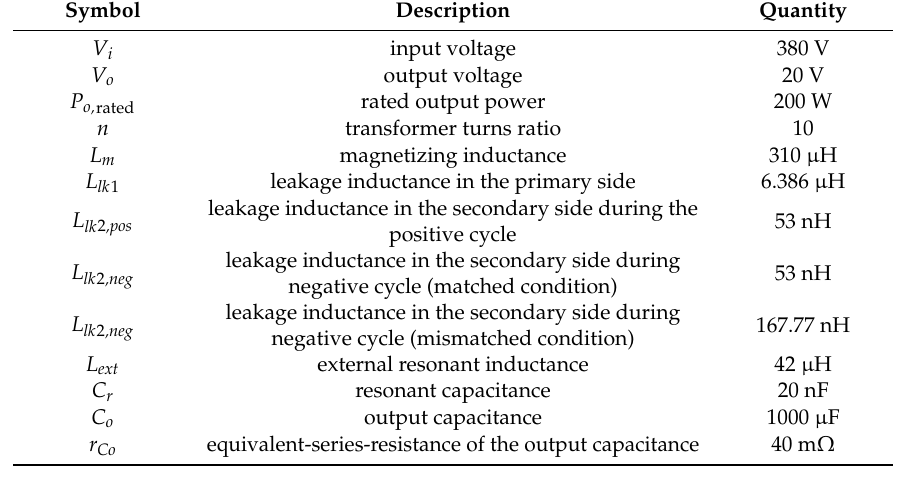
Figure 13. Control block diagram of the flux-balance loop.